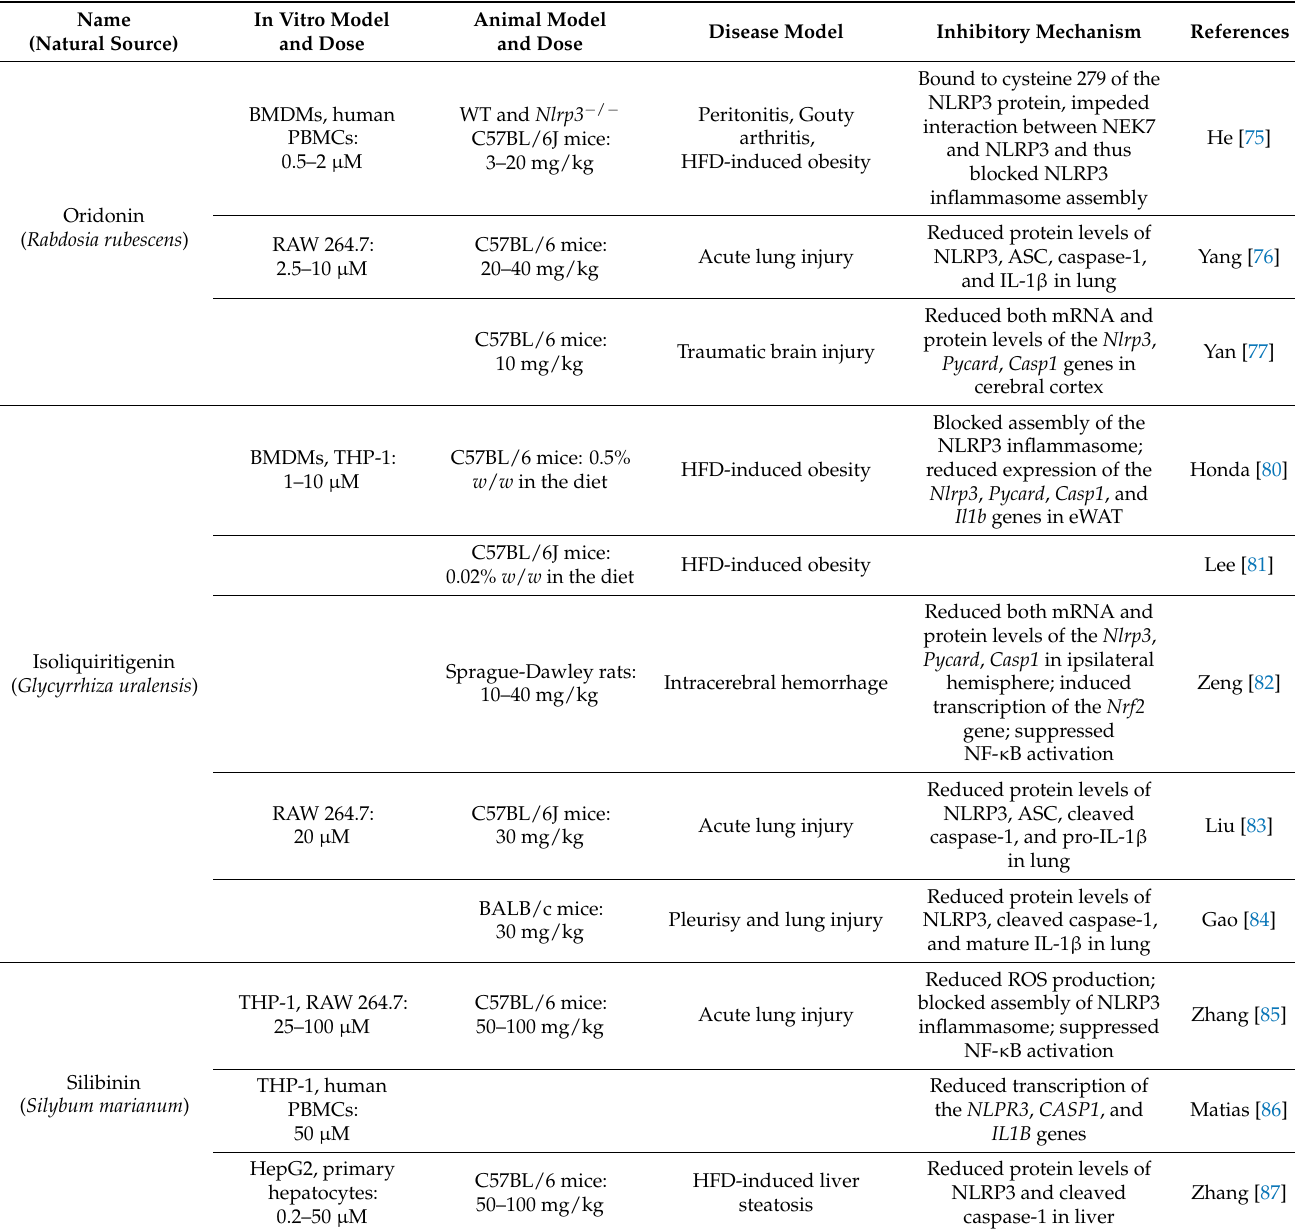
Table 1. Natural compounds with anti-NLRP3 inflammasome